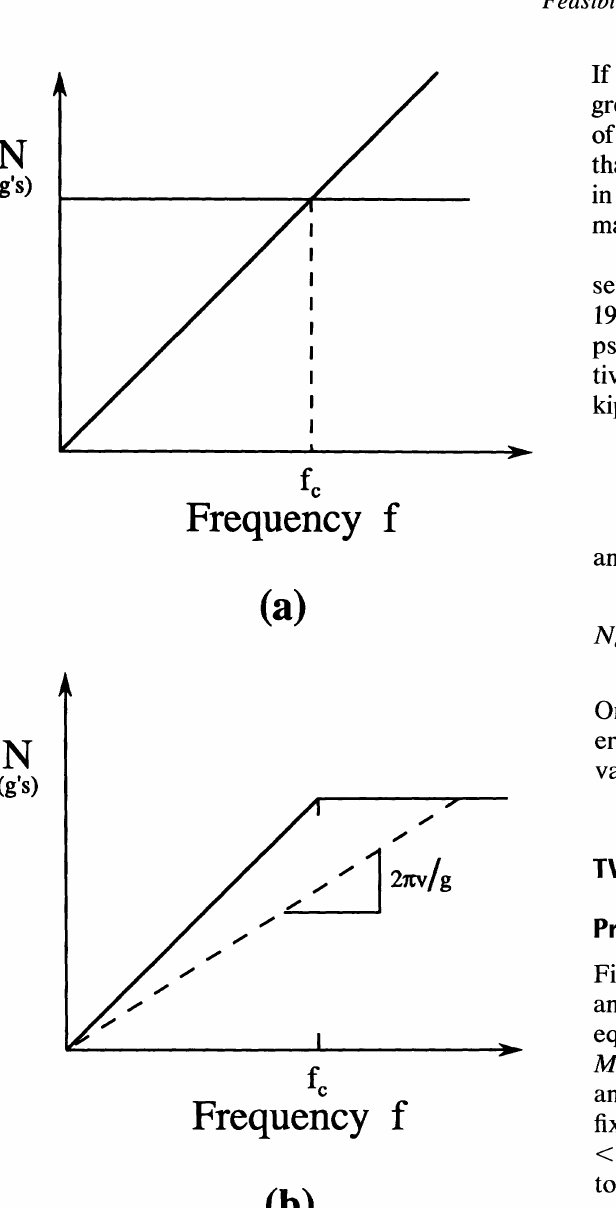
FIGURE 3 (a) The acceptable value of N for a given frequency fis the lesser of the two available values. (b) Example for finding the pseudo velocity v whenf> fe.